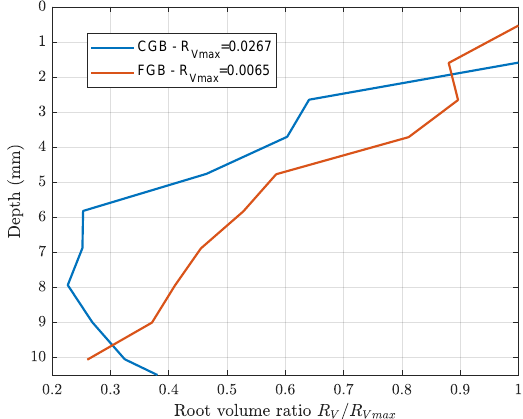
Figure 3. Void ratio profile estimated at di ff erent radii from the root centroid for (a) coarse and (b) fine glass ballotini.